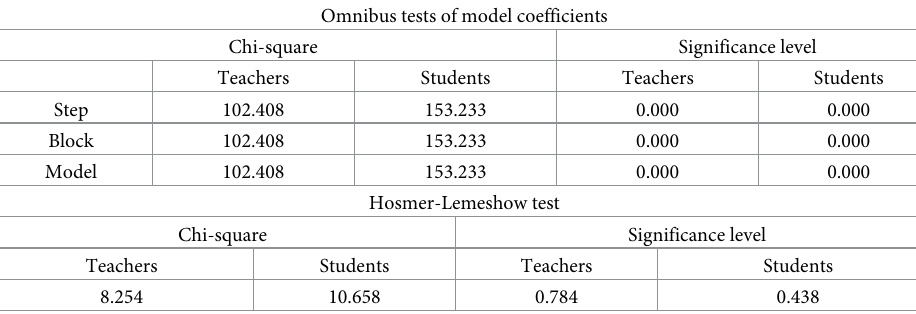
Table 4. Omnibus tests of model coefficients and Hosmer-Lemeshow